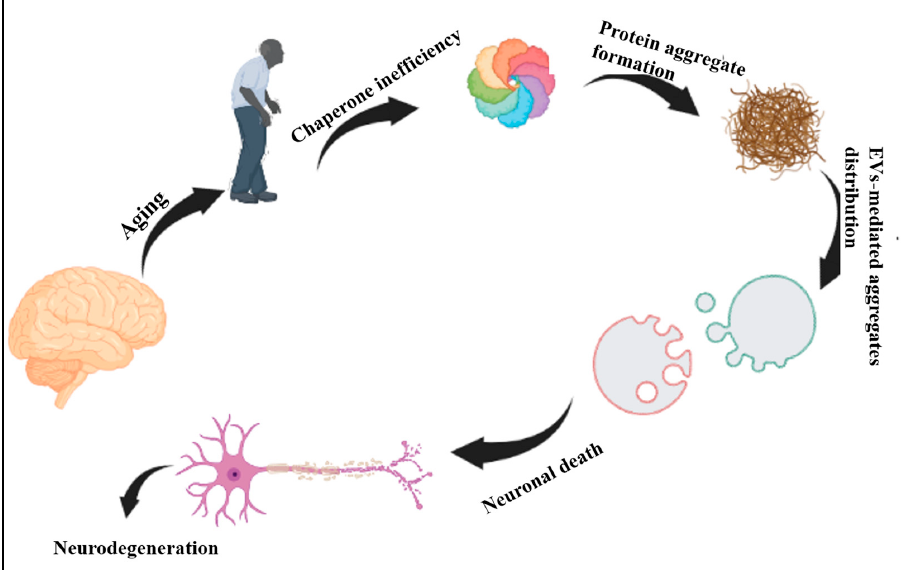
Figure 2. Schematic explanation of the role of chaperones and EVs in the induction and propagation of neurodegeneration. of neurodegeneration.